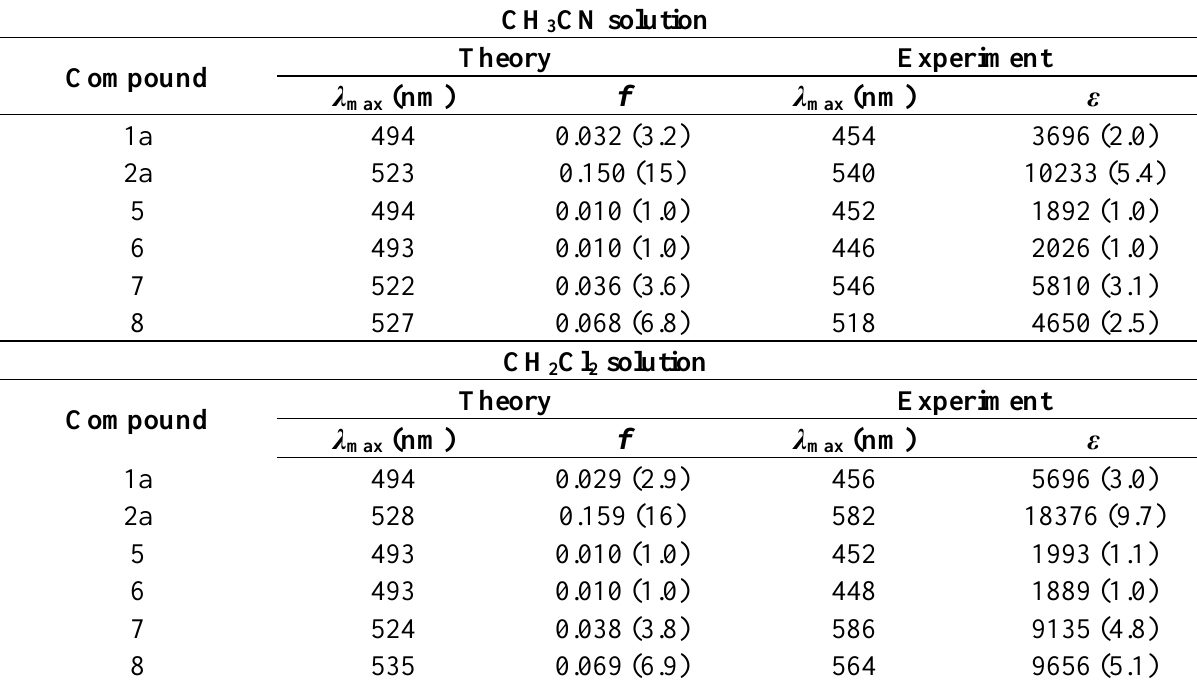
Figure 5. Molecular orbitals (Contour value = 0.04) involved in the electronic transitions of: (a) λ = 494 nm for compound 1, and (b) λ max